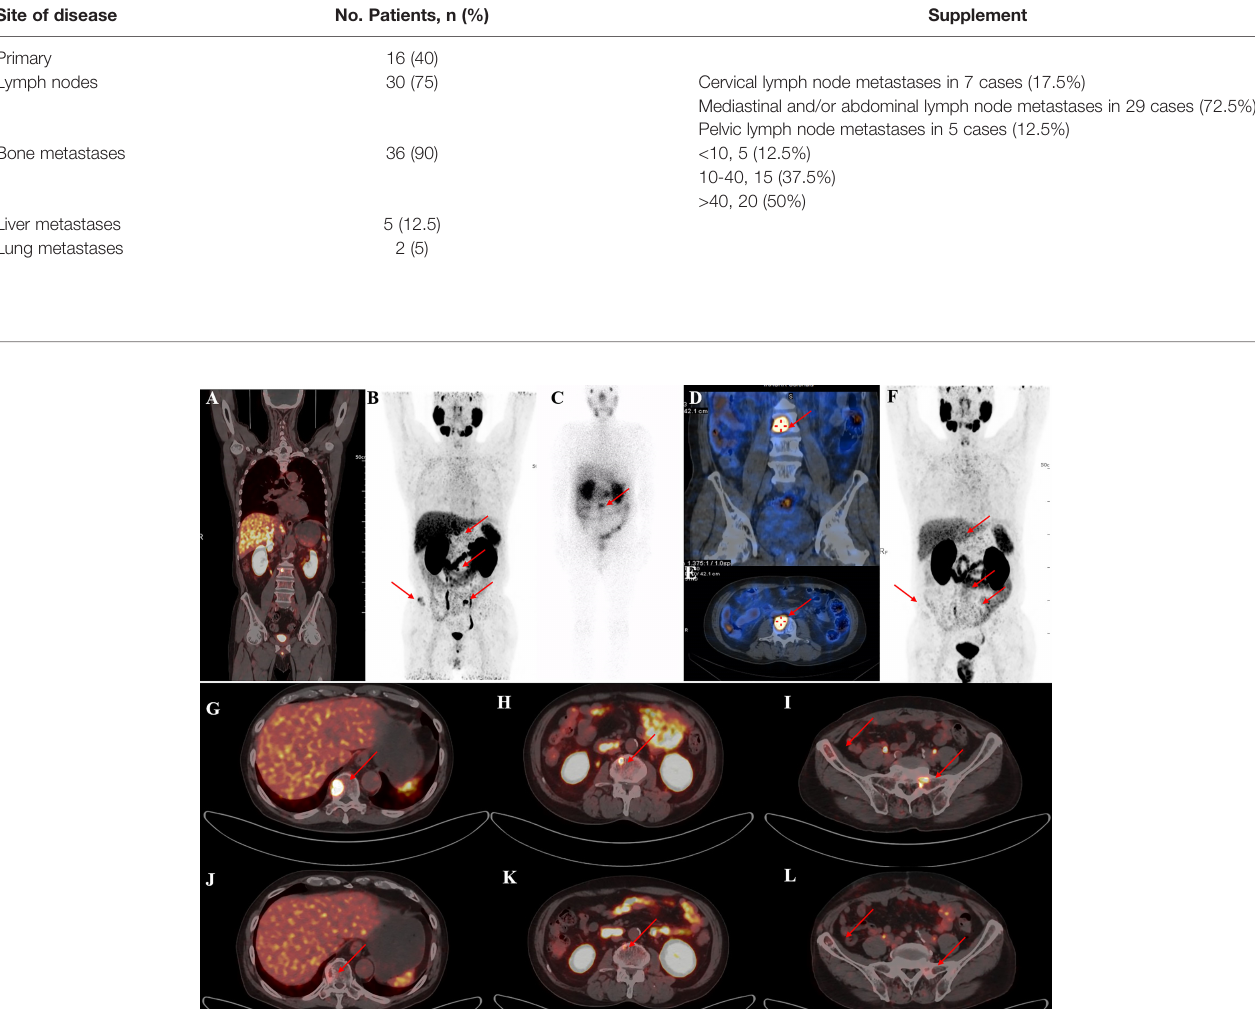
TABLE 2 | Extent of Disease on Baseline